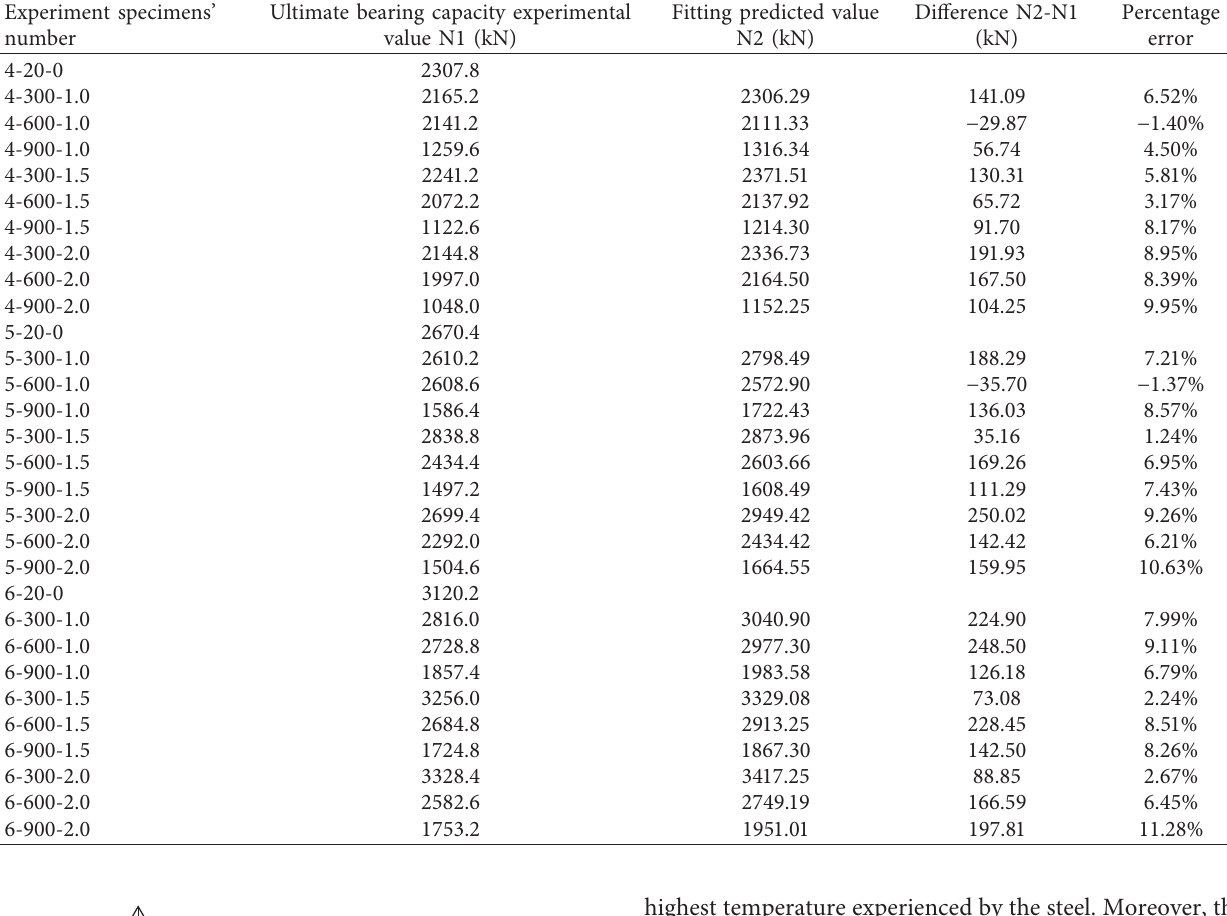
Table 6: Fitting analysis of ultimate bearing capacity of specimens.